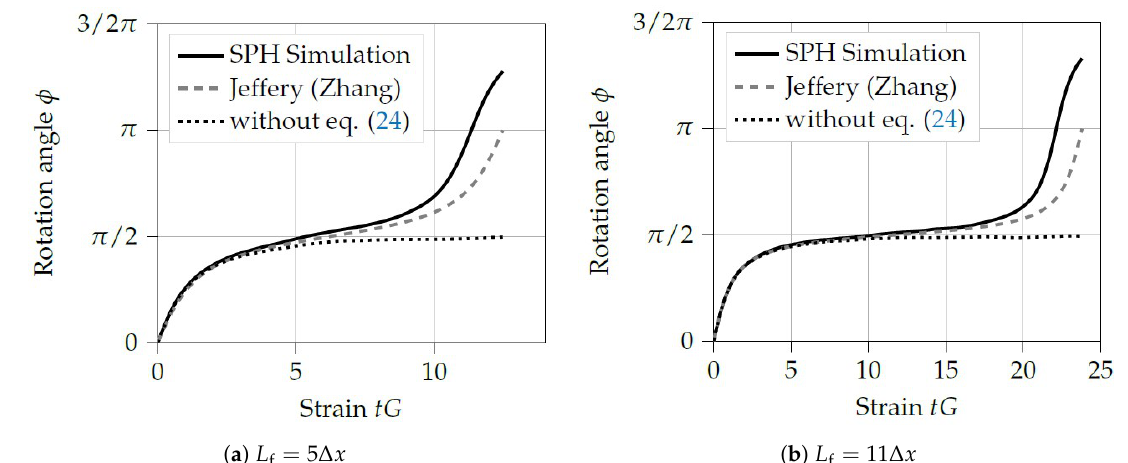
Figure 5. Orientation angle φ for fiber in a shear flow. The fiber length L f is expressed in multiples of the particle spacing ∆ x . The dashed gray line represents the solution to Jeffery’s equation with Zhang’s [53] fit. The solid black line represents the solution obtained with this SPH implementation. If the viscous surface traction term (Equation (24)) is neglected, the fiber stops rotating after one half rotation, as shown with the black dotted line.